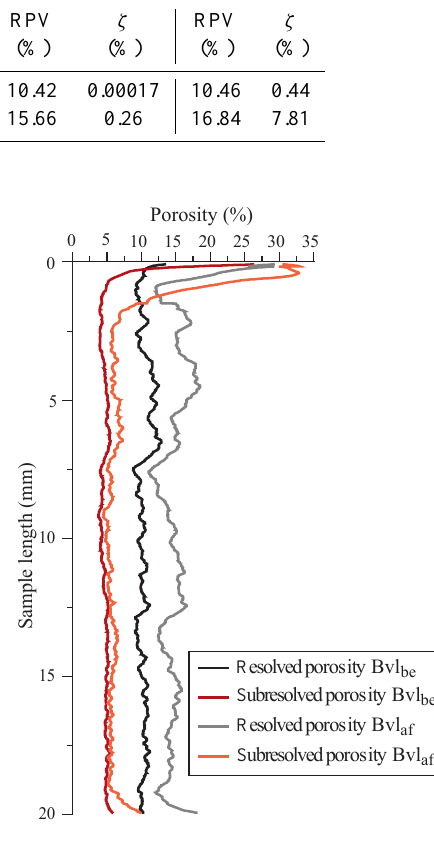
Figure 8. Porosity changes along samples Bvl be and Bvl af . Both resolved and sub-resolved porosities are